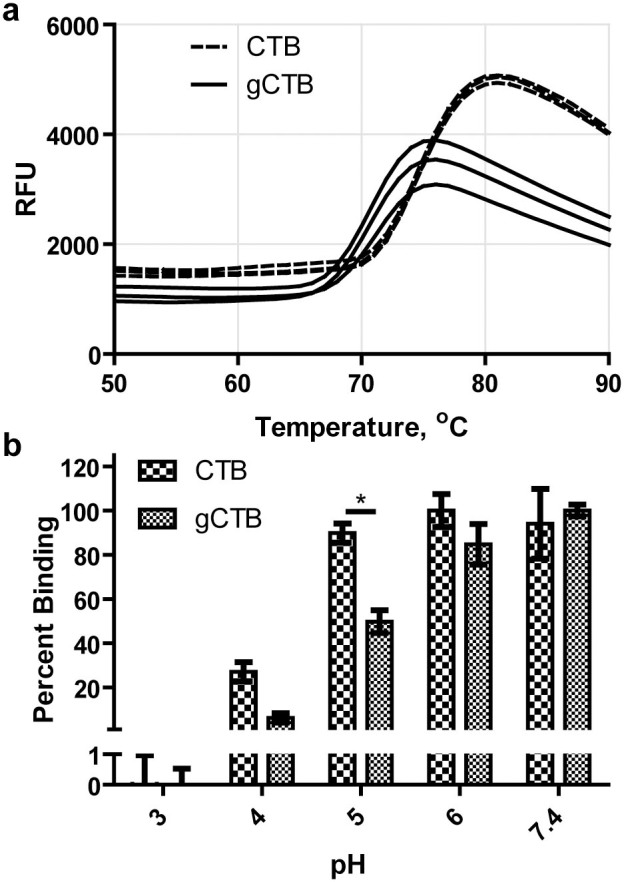
Thermal and acid stability of gCTB.(a) Melting temperature (Tm) determination using DSF. CTB (dashed line, n = 3) and gCTB (solid line, n = 3) were analyzed. Tm values of CTB and gCTB were 74.2 and 70.9°C, respectively, as determined by the vertex of the first derivative of relative fluorescence unit (RFU) values. (b) pH stability analysis. CTB and gCTB were incubated in various pH buffers26, and GM1-bound CTB proteins were quantified by GM1-ELISA. The results were normalized to the average value of the corresponding CTB protein at pH 7.4 and expressed as % binding. Data represent means ± SEM (n = 3); * P < 0.05, unpaired two-tailed t-test.